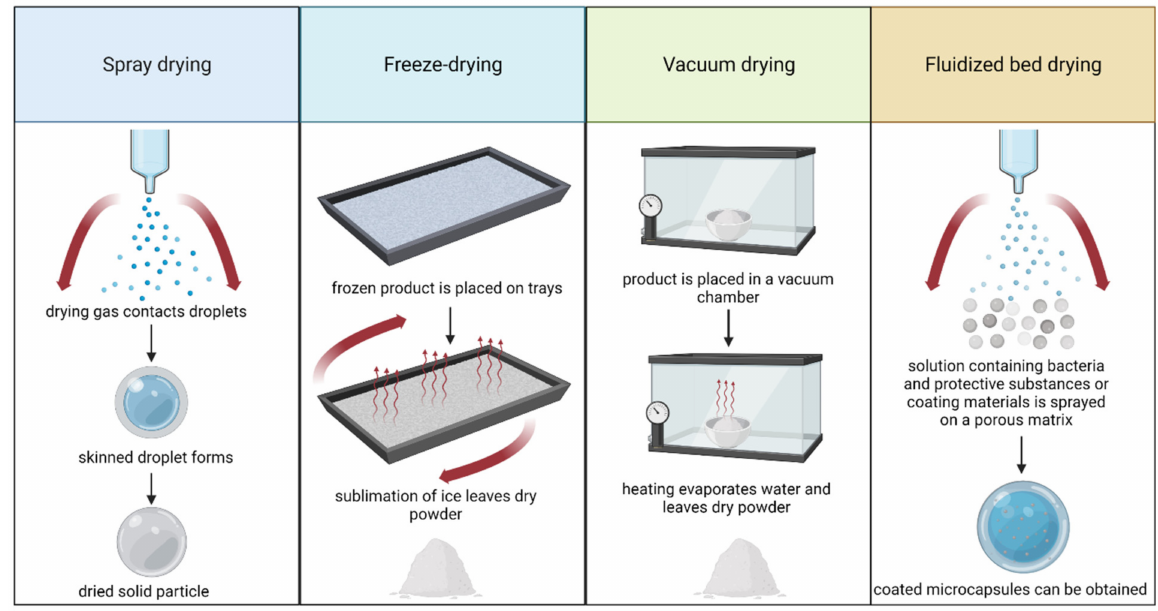
Figure 1. Summary of the basic principles for the most commonly applied drying techniques. Created with Biorender.com (accessed on 27 July